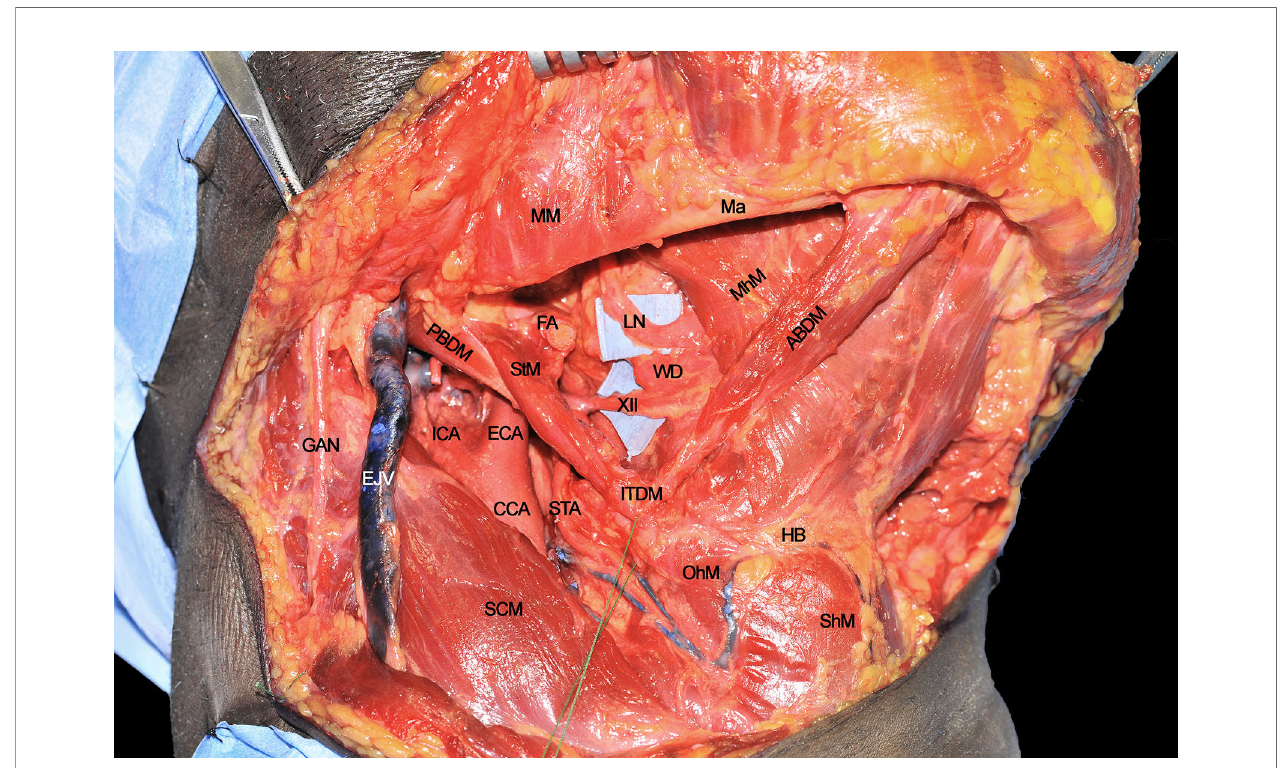
FIGURE 3 | ABDM, anterior belly of digastric muscle; CCA, common carotid artery; ECA, external carotid artery; EJV, external jugular vein; FA, facial artery; GAN, great auricular nerve; HB, hyoid bone; ICA, internal carotid artery; ITDM, intermediate tendon of digastric muscle; LN, lingual nerve; Ma, mandible; MhM, mylohyoid muscle; MM, masseter muscle; OhM, omohyoid muscle; PBDM, posterior belly of digastric muscle; SCM, sternocleidomastoid muscle; ShM, sternohyoid muscle; STA, superior thyroid artery; StM, stylohyoid muscle; WD, Warthon ’ s duct; XII, hypoglossal